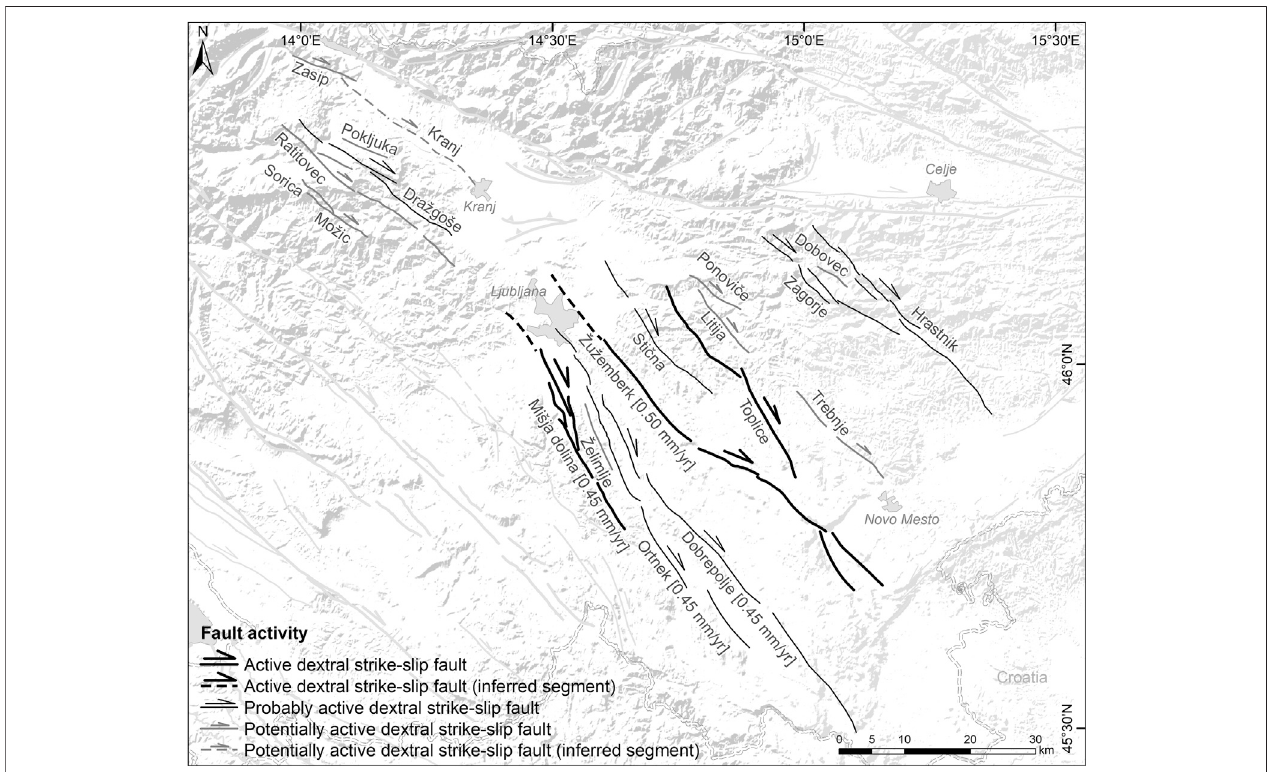
FIGURE 7 | Eastern fault set of the Dinaric fault system and the dextral strike-slip faults of the Sava compressive wedge. The dominant faults are the Mi ˇ sja dolina fault, the Ortnek fault, the Dobrepolje fault and the ˇ Zu ˇ zemberk fault.